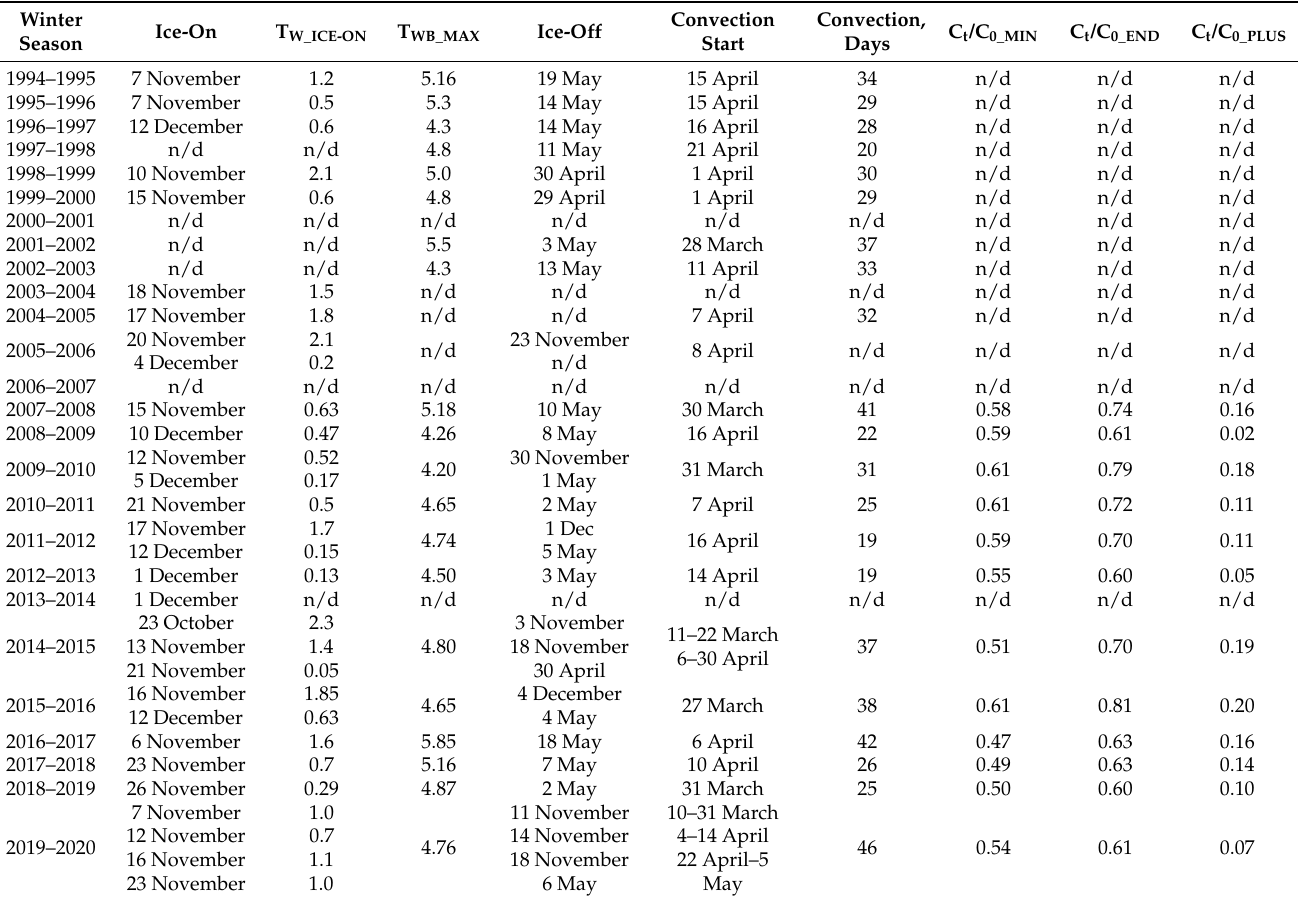
Table 2. Dates of ice-on, ice-off and start of spring under-ice convection, water temperature on ice-on date (T W_ICE-ON ), maximal bottom water temperature at the end of winter (T WB_MAX ), duration of convection, minimal C t /C 0 during winter (C t /C 0_MIN ), values of C t /C 0 on the last day of the ice season (C t /C 0_END ), and increase in C t /C 0 during convection (C t /C 0_PLUS ) according to field